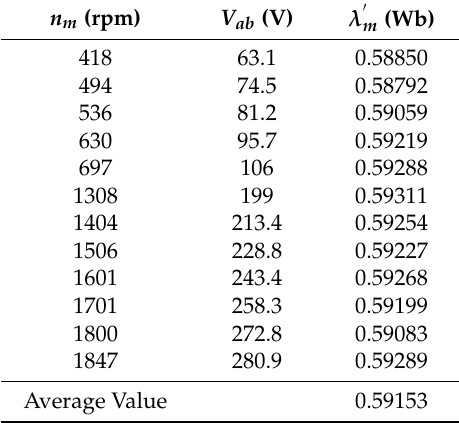
Table 8. Open-circuit test